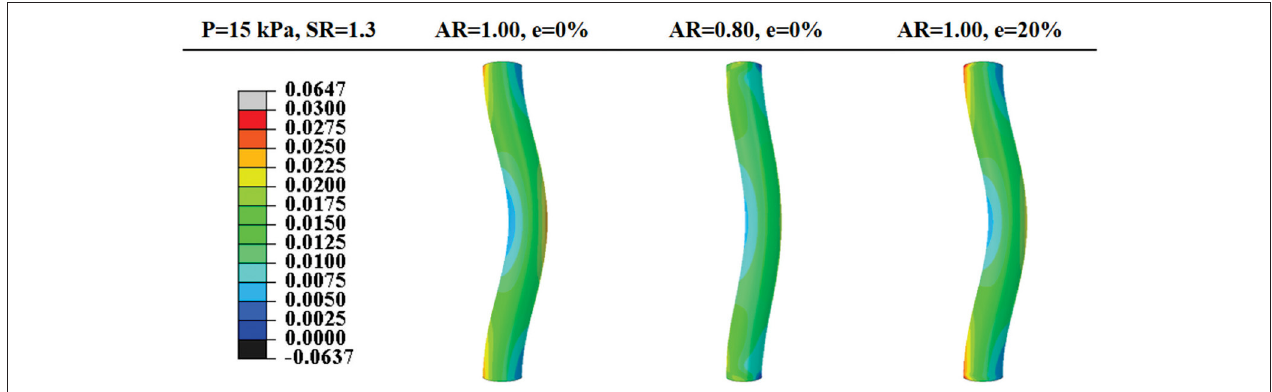
FIGURE 5 | Comparison of post-buckling axial stress distributions in arteries with concentric circular and oval lumen shape and eccentric circular lumen shape (all under an axial stretch ratio of 1.3 and a lumen pressure of 15 kPa). Values of the color bar are in MPa.